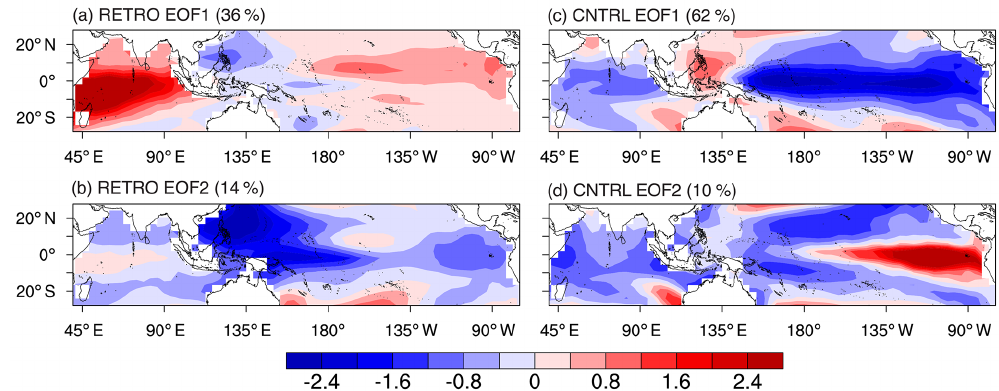
Figure A1. Two leading EOFs of yearly SST anomaly (30 ◦ S–30 ◦ N, 40 ◦ E–60 ◦ W): RETRO (a, b) and CNTRL (c, d)